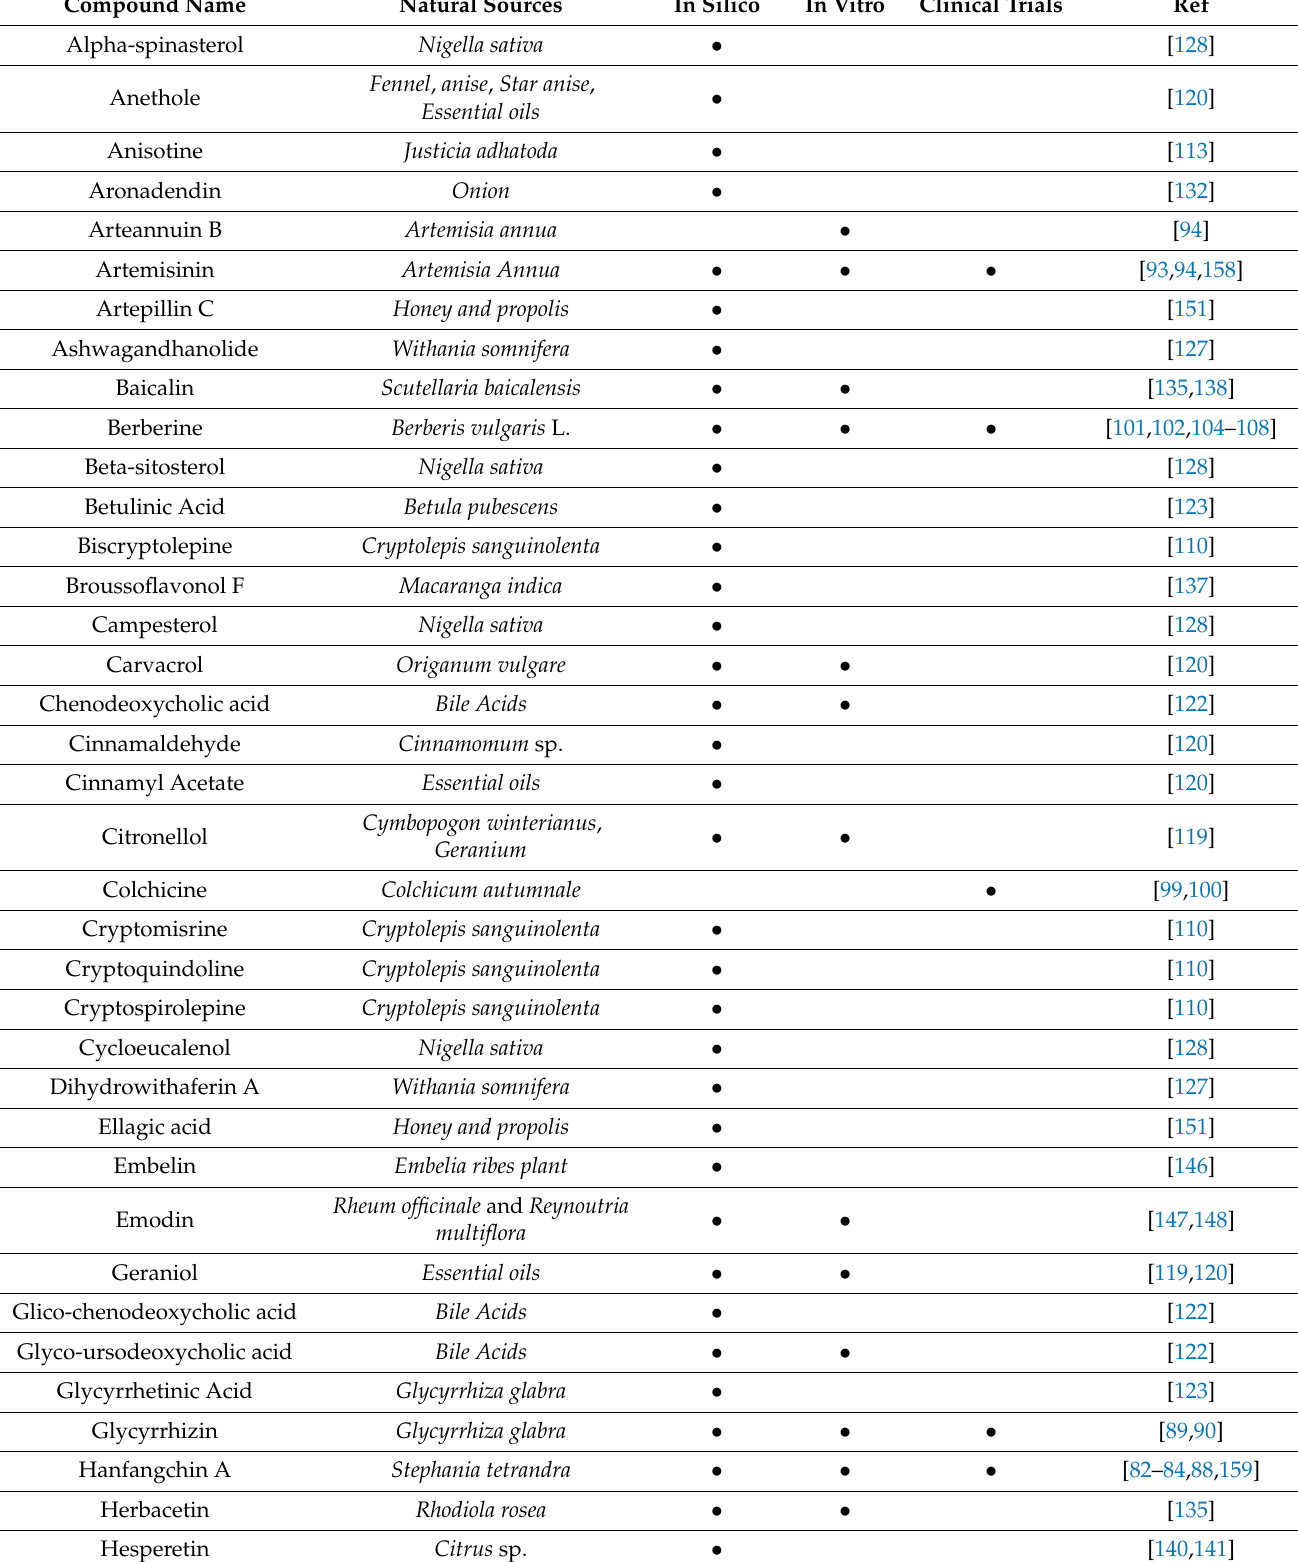
Table 1. Naturally occurring compounds recognizing SARS-CoV-2 druggable targets under